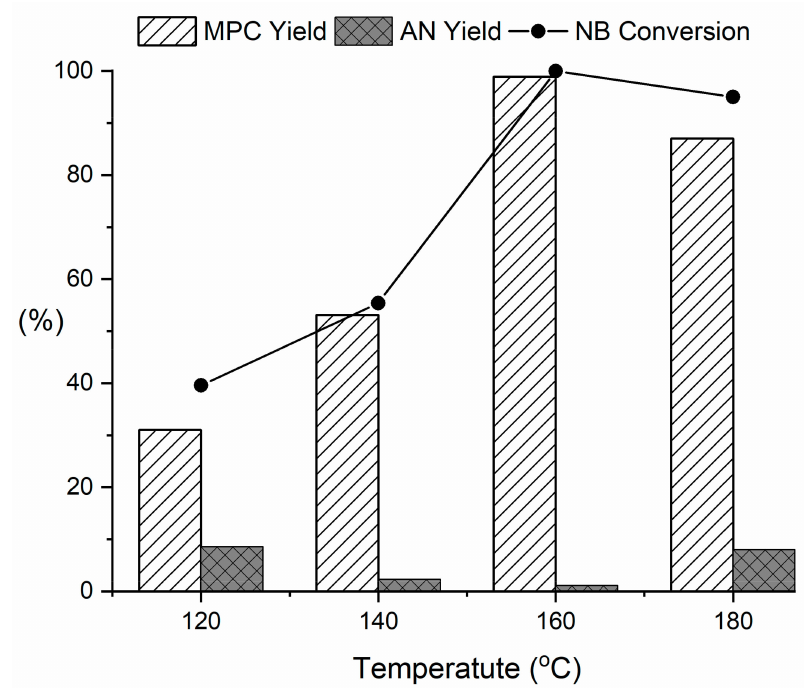
Figure 4. E ff ect of temperature on the formation of MPC at 8.3 MPa of CO for 4 h in the presence of 1 g of 5 wt% FeSe 2 / γ -Al 2 O 3 . Conditions: NB (20 mmol), 5 wt% FeSe 2 / γ -Al 2 O 3 (1 g, [FeSe 2 ]: 0.2338 mmol), molar ratio of NB / FeSe 2 = 85, MeOH (30 mL), p = 8.3 MPa of CO, t = 4 h.